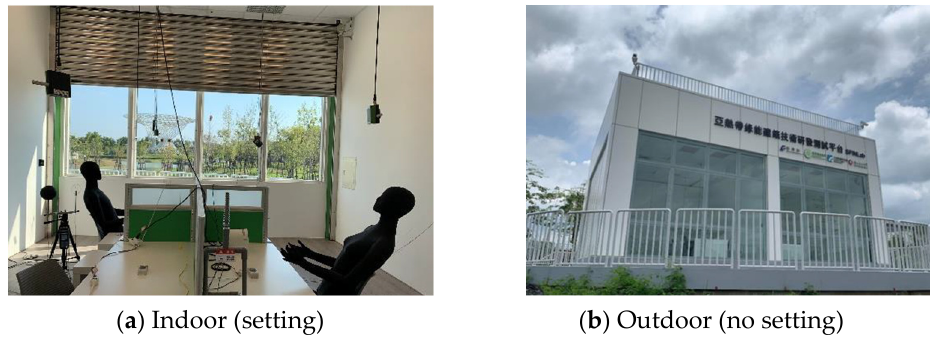
Figure 1. Indoor and outdoor environments of SPINLab